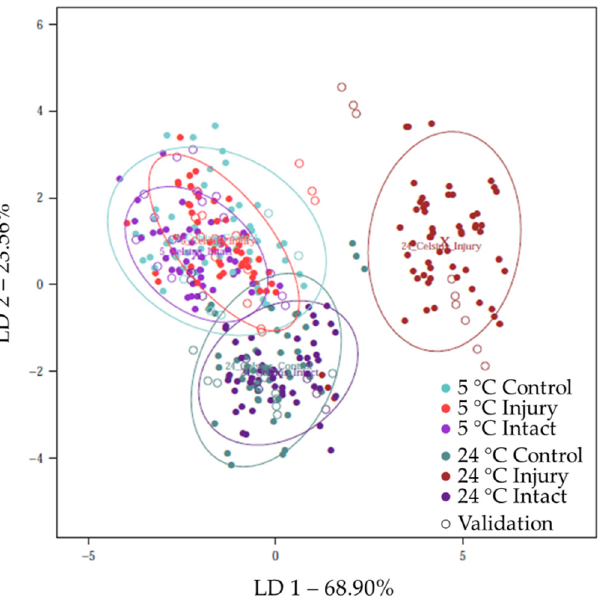
Figure 2. PCA-LDA classification model on the NIRS data of control and infected plums from measurement day 8 with first parallel sample data validation when the different treatment groups were used as class variable ( N = 357, NrPCs = 12).